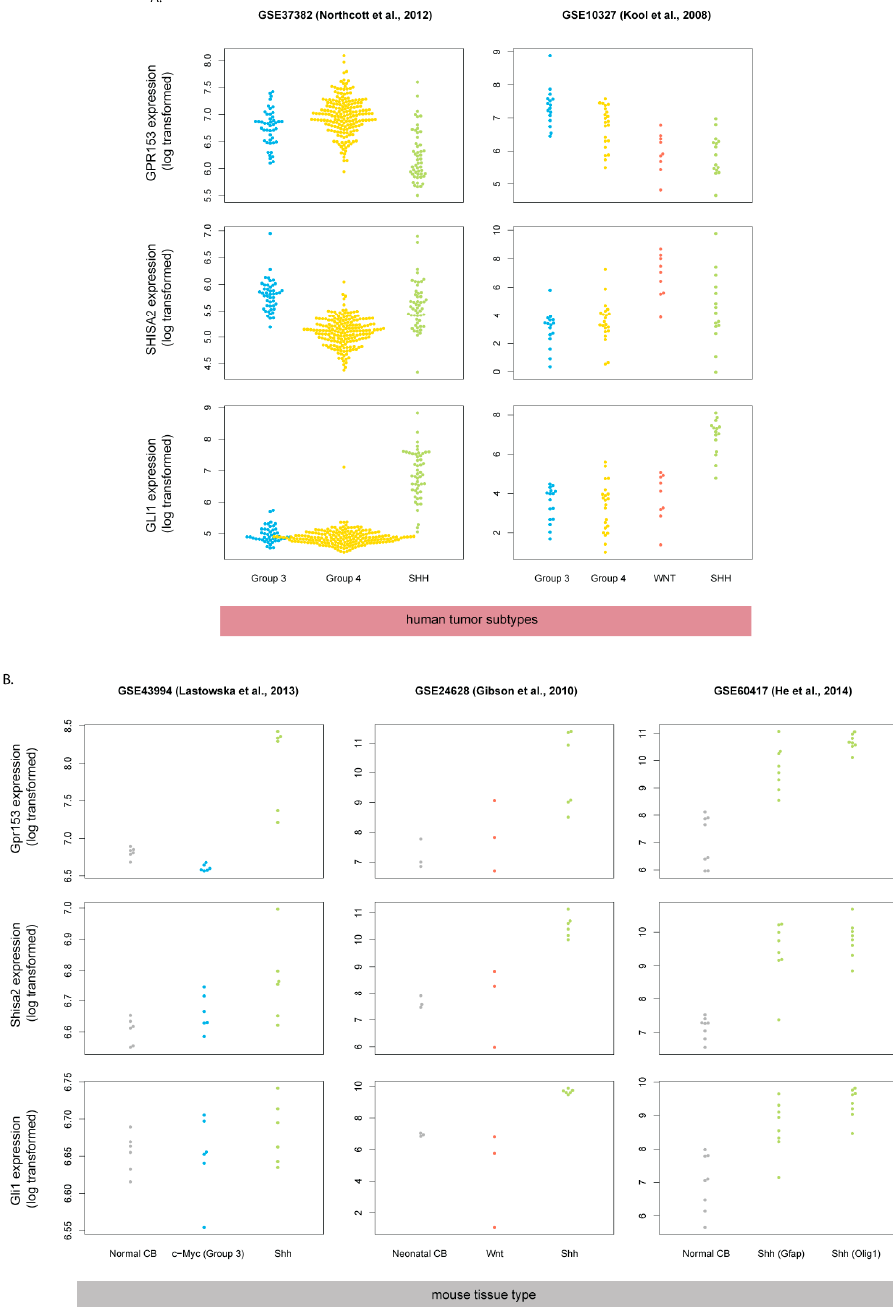
Figure 2. GPR153 and SHISA2 are not upregulated in human SHH-MB. Expression data derived from microarray analysis were downloaded from GEO (accession numbers and corresponding citations are shown) and reanalyzed. Gli1/GLI1 is upregulated in both human ( A ) and mouse ( B ) Shh-MB samples, whereas overexpression of Gpr153/GPR153 and Shisa2/SHISA2 is limited to mouse Shh-MB.